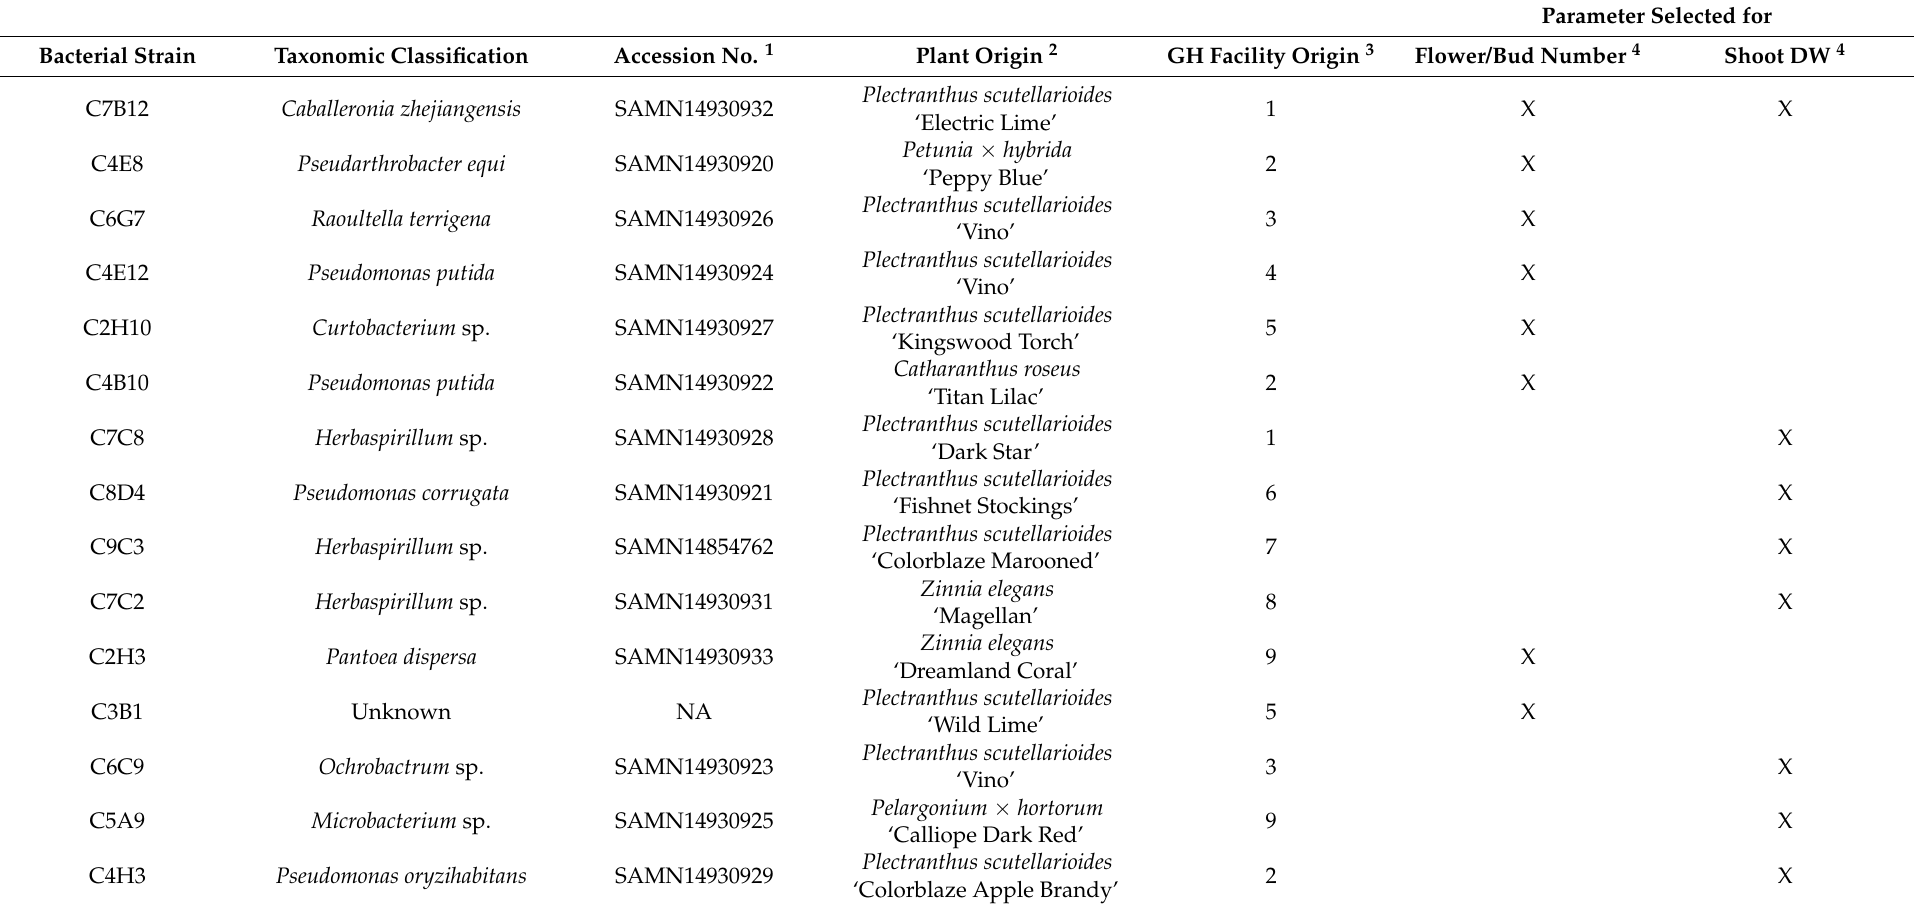
Table 1. Top 15 bacterial strains selected from the high-throughput greenhouse